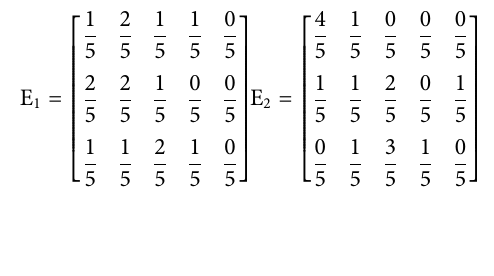
TABLE 3 | Single factor membership degree of toilet improvement effect in rural areas of Inner Mongolia. Evaluation